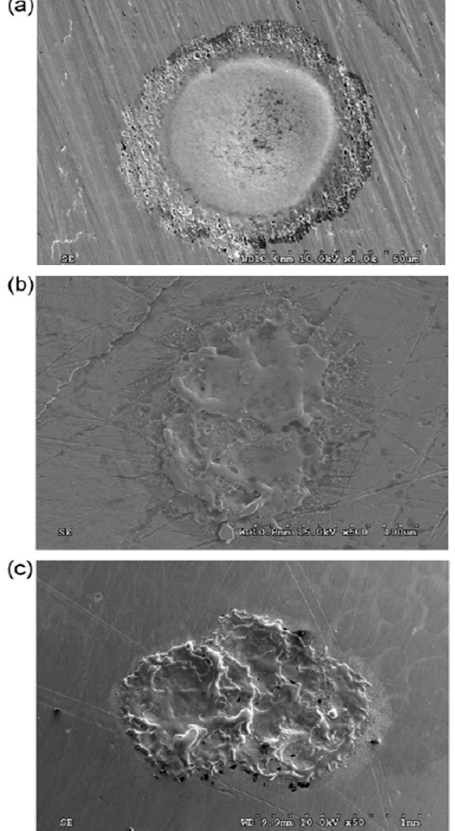
Figure 7. Types of craters during individual discharge ( a ) for small values of peak amperage and short pulse time, ( b ) for intermediate parameter values, and ( c ) for high amperage and long spark discharge time [174].